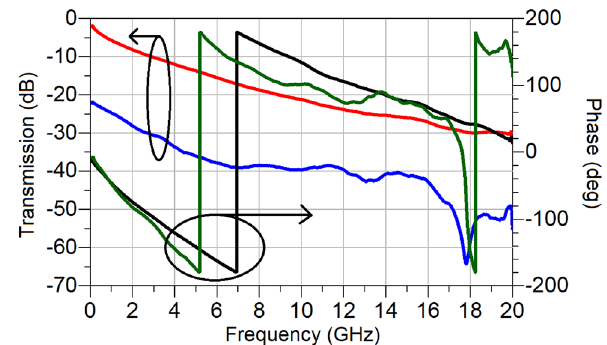
Figure 12. Extracted reflection-less transmission coefficients of amorphous TiO 2 ; red (OFF state, magnitude), blue (ON state 7 V, magnitude), black (OFF state, phase) and green (ON state 7 V,